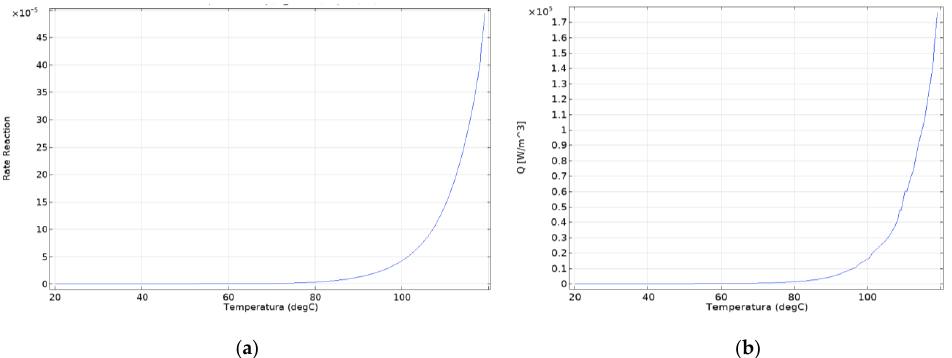
Figure 9. ( a ) Curve of reaction rate vs. temperature (Equation (9)); ( b ) heat generation by decomposition reactions (Equation (10)).